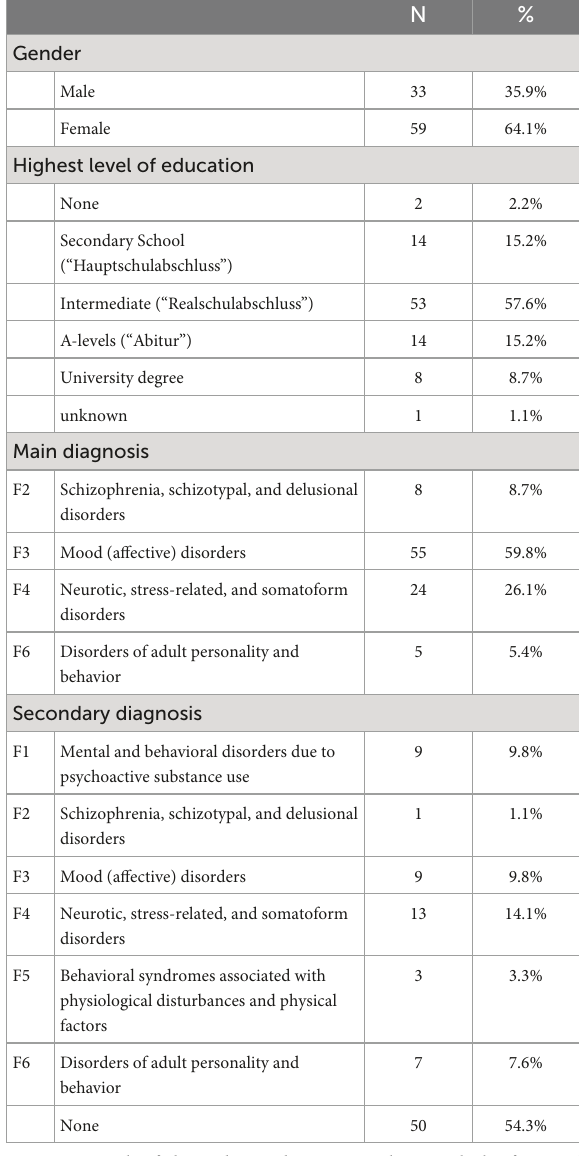
TABLE 1 Characteristics of